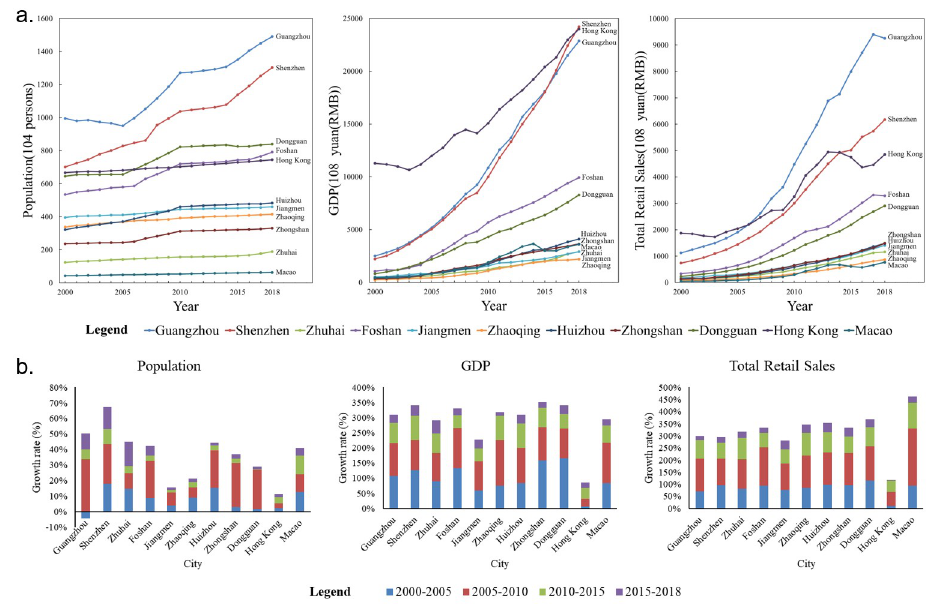
Fig 4. The changes in (a) and growth rates of (b) the populations, GDP and total retail sales of the different